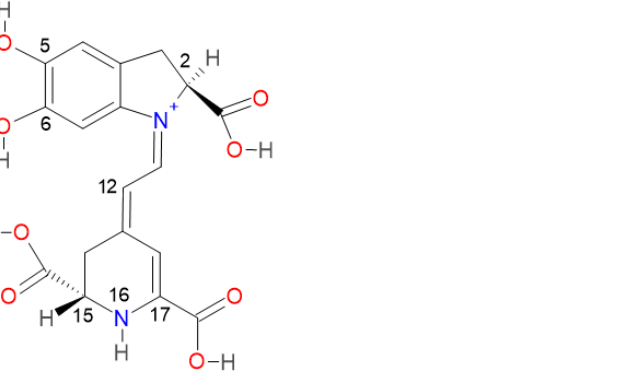
Figure 1. Chemical structures and atom numbering system of betanidin (Bd).